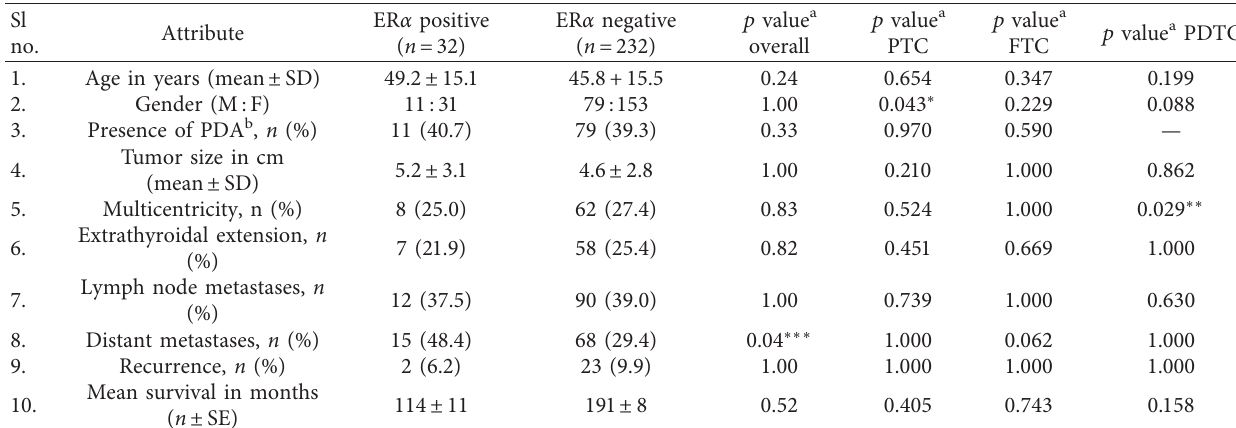
Figure 1: Photomicrographs depicting intranuclear immunostaining of ER α in PTC (a), ER β in PTC (b), and ER β in PDTC (c) and membranous immunostaining of HER-2 in PTC (d) and FTC (e). Table 1: Clinicopathologic correlation of ER α